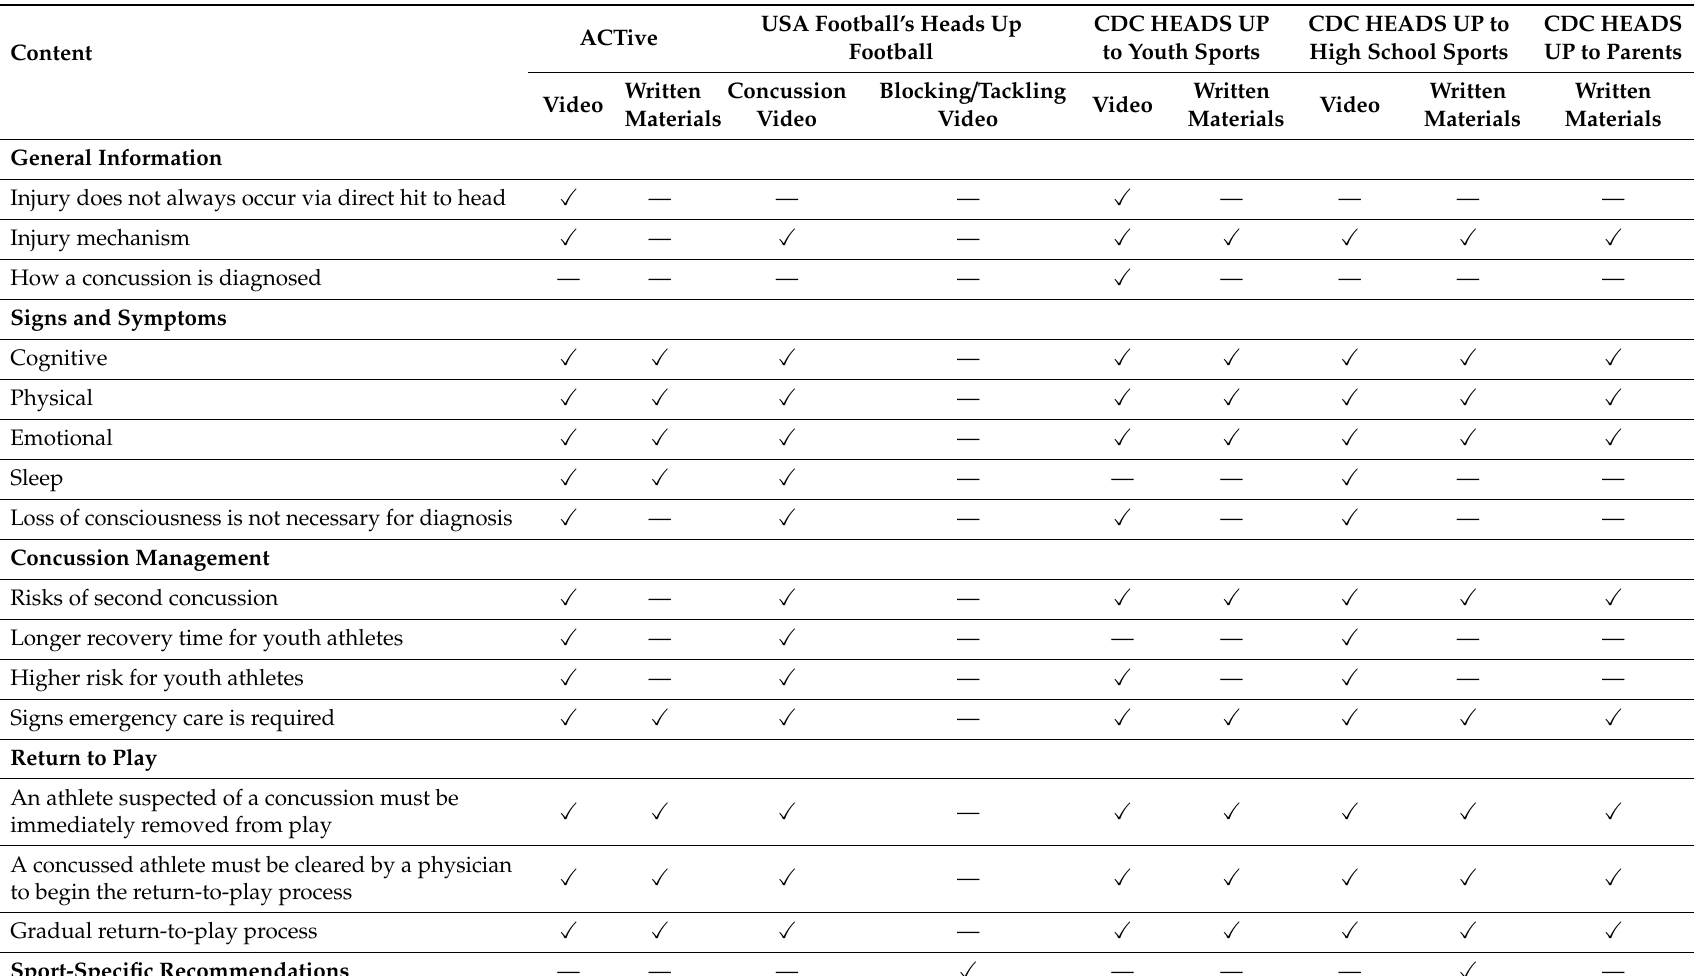
Table 2. Comparison of Concussion Education Program